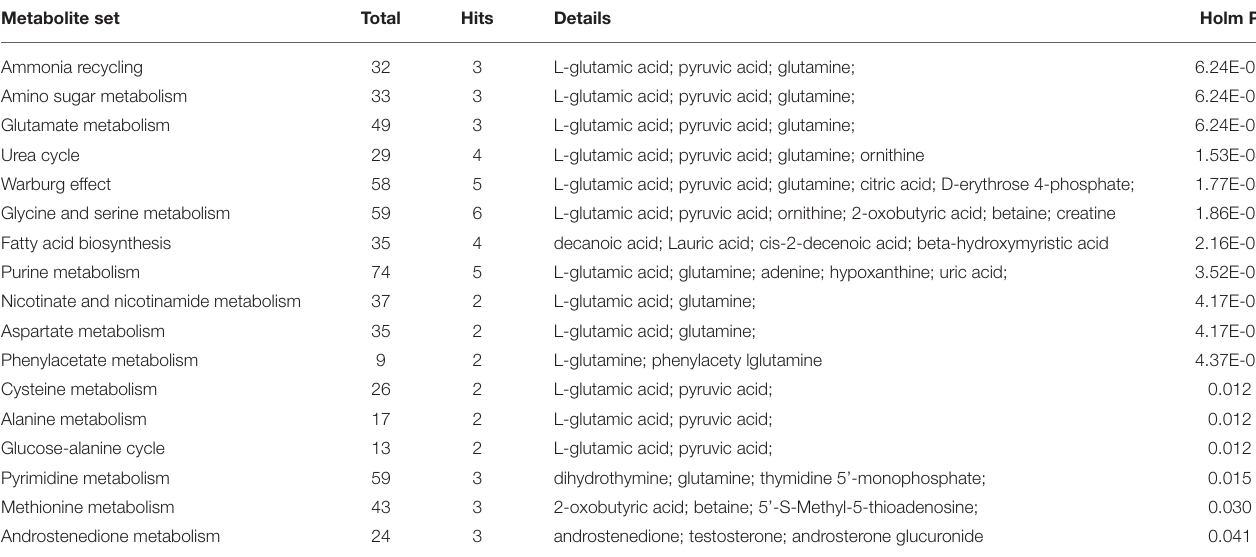
TABLE 2 | Differential metabolic pathways enriched from MDD group. Metabolite set Total Hits